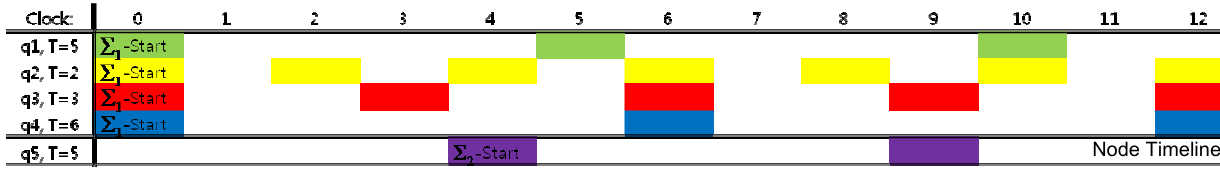
Figure 6. Timeline of queries sent to a node. The numbers indicate the time of the readings from the node clock. Each colored box indicates query execution.